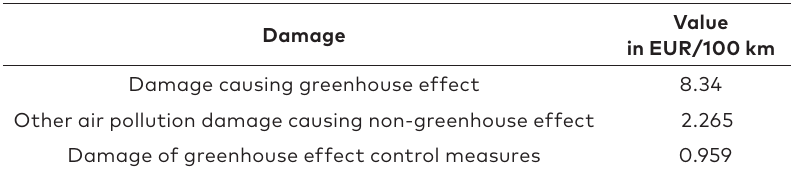
Reduced value of costs for prevention of